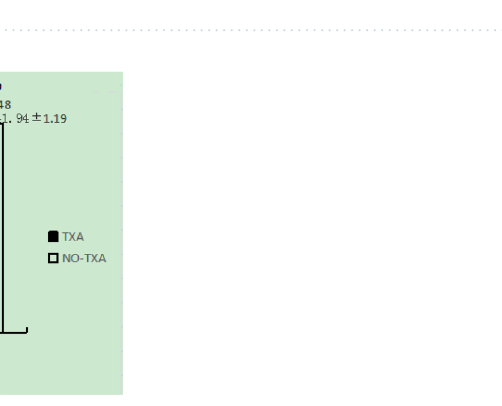
Figure 3. The ROM of both groups at each follow up. The TXA group is shown as black bars and the NO-TXA group is shown as white